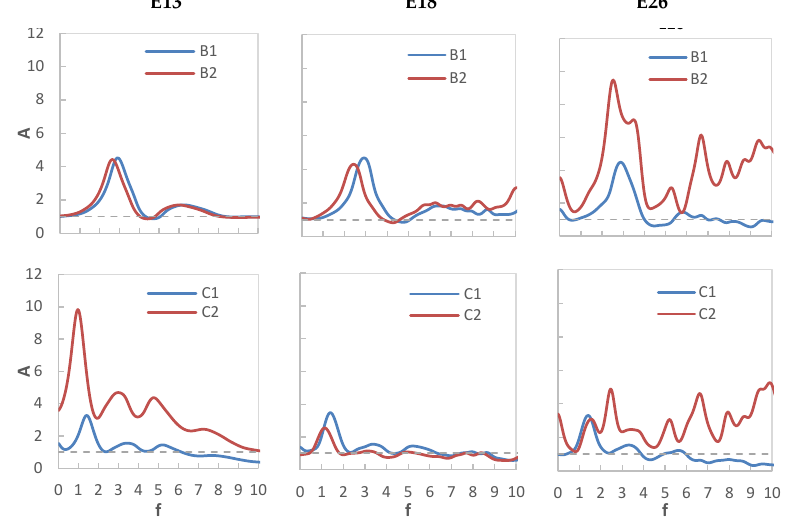
Figure 14. Comparison between the amplification functions obtained for the SS alignment (visco-nonlinear analyses).